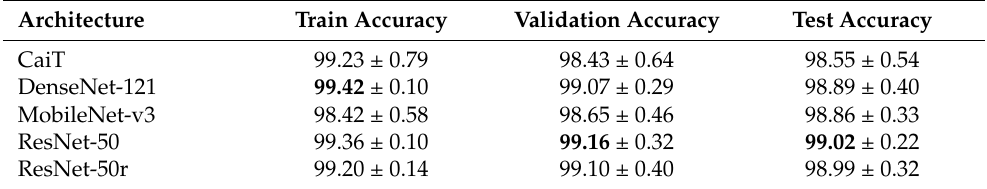
Table 4. Train, validation and test accuracy by architecture before bootstrapping for all architectures.